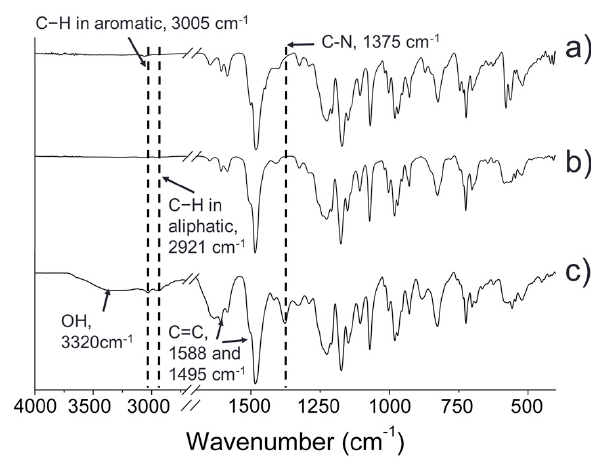
Figure 4. FT-IR spectra of ( a ) PAES X10Y13, ( b ) CM-PAES X10Y13, and ( c ) QN-PAES X10Y13.